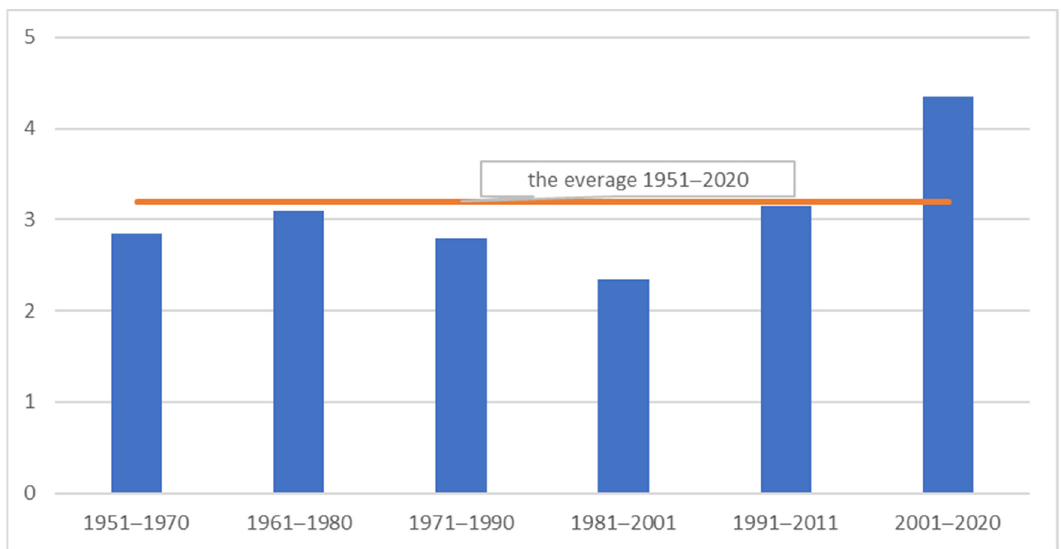
Figure 7. The average number of days with daily precipitation above 20 mm at the Białystok weather station, in 20-year periods.